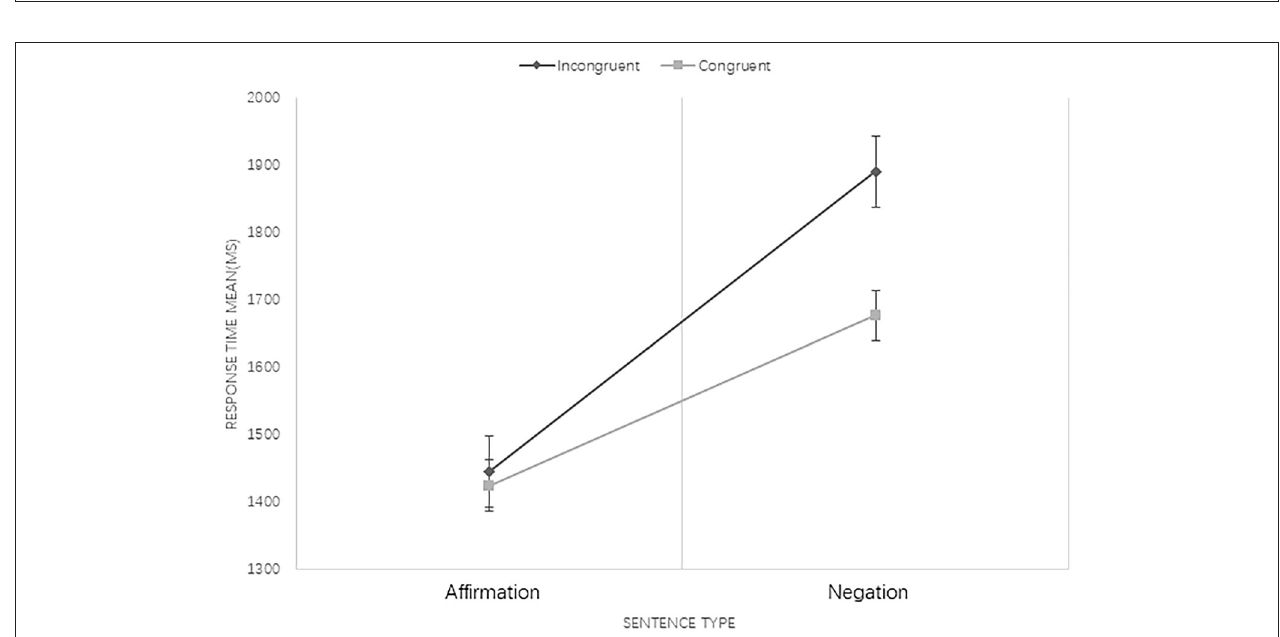
FIGURE 2 | The interaction between congruency condition and sentence type at 250 ISI. Bars represent standard error.